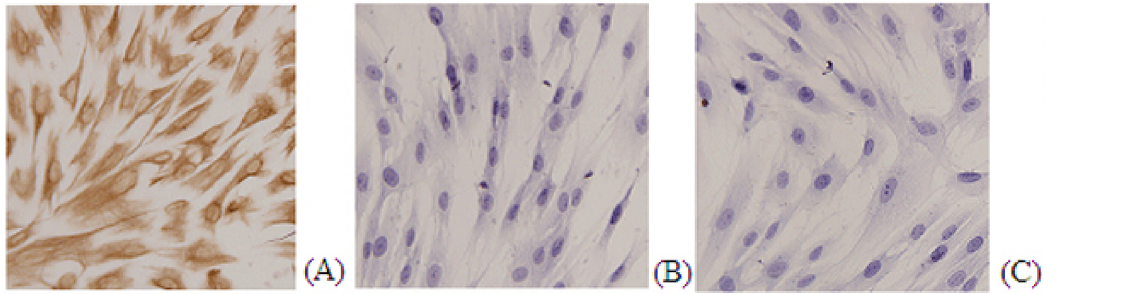
Fig 1. Immunostaining for vimentin (A) cytokeratin (B) and negative control (C) on ESC primary culture.